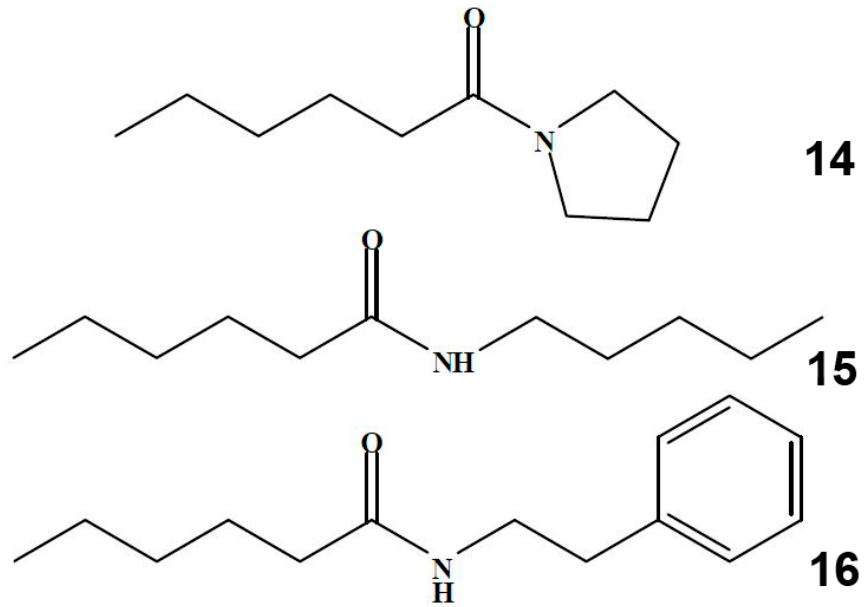
Figure 5. Structures of the most active compounds.